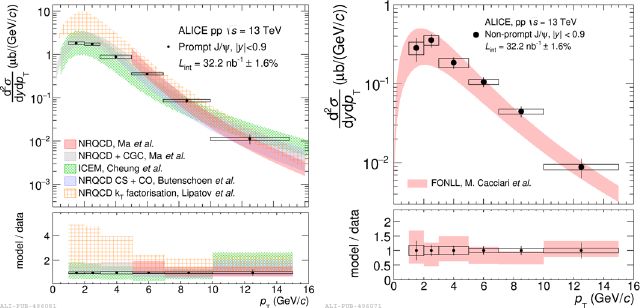
Figure 2. The prompt (left) and non-prompt (right) J / ψ cross section as a function of p T , in pp collisions at √ s = 13 TeV and midrapidity